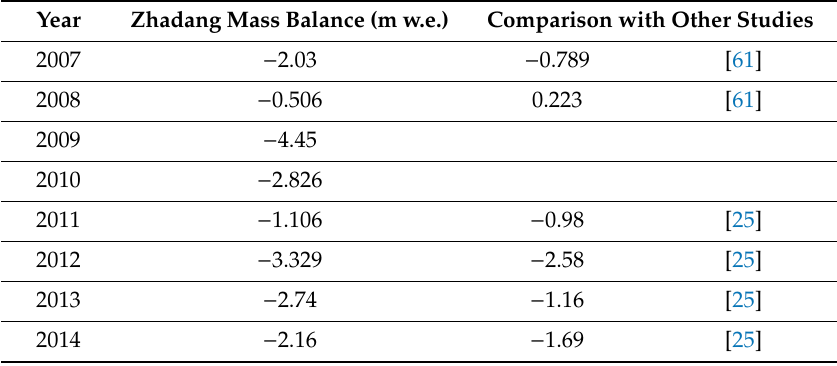
Table 4. Simulated GMB of the Zhadang glacier and compared with others. Year Zhadang Mass Balance (m w.e.) Comparison with Other